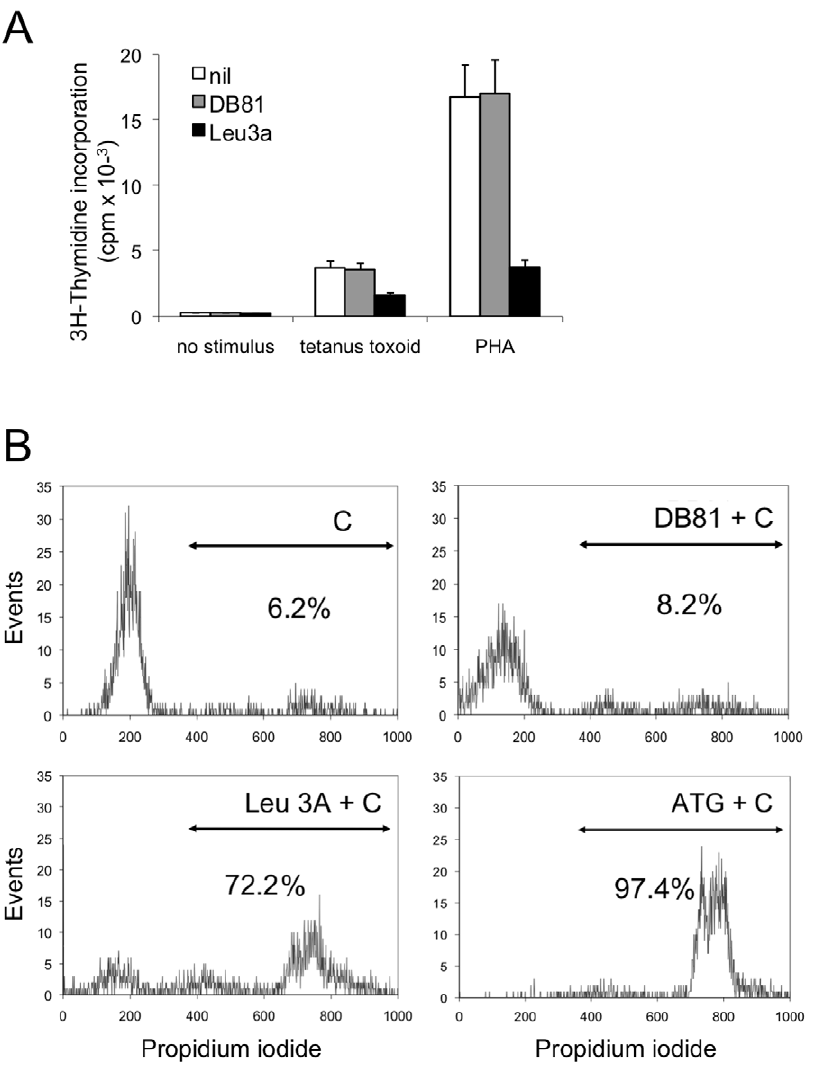
Figure 8. Immunosuppressive and complement-fixing effects of MAb DB81. A. Inhibition of PBMC proliferation by MAb DB81. PBMC from 4 healthy blood donors were incubated with the indicated stimuli in a 5-day proliferation assay. Either no inhibitors (‘‘nil’’) or the indicated mAbs (3 m g/ ml) were added at the beginning of the culture time. Proliferation was measured by incorporation of tritiated thymidine in triplicate wells. The values indicate the mean 6 standard error of the mean. B. Complement fixation by MAb DB81. Flow cytometry analysis of PM-1 cells treated with complement only (C, top left) or with C plus thymoglobulin (polyclonal rabbit antibodies to human thymocyte antigens, ATG, bottom right), C plus MAb Leu-3a (bottom left) or C plus DB81 (top right). Cells were stained with propidium iodide as a marker for cell death. Numbers in panels indicate the percent of stained (complement lysed, dead) cells, which fell within the double arrow markers in the different experimental settings.